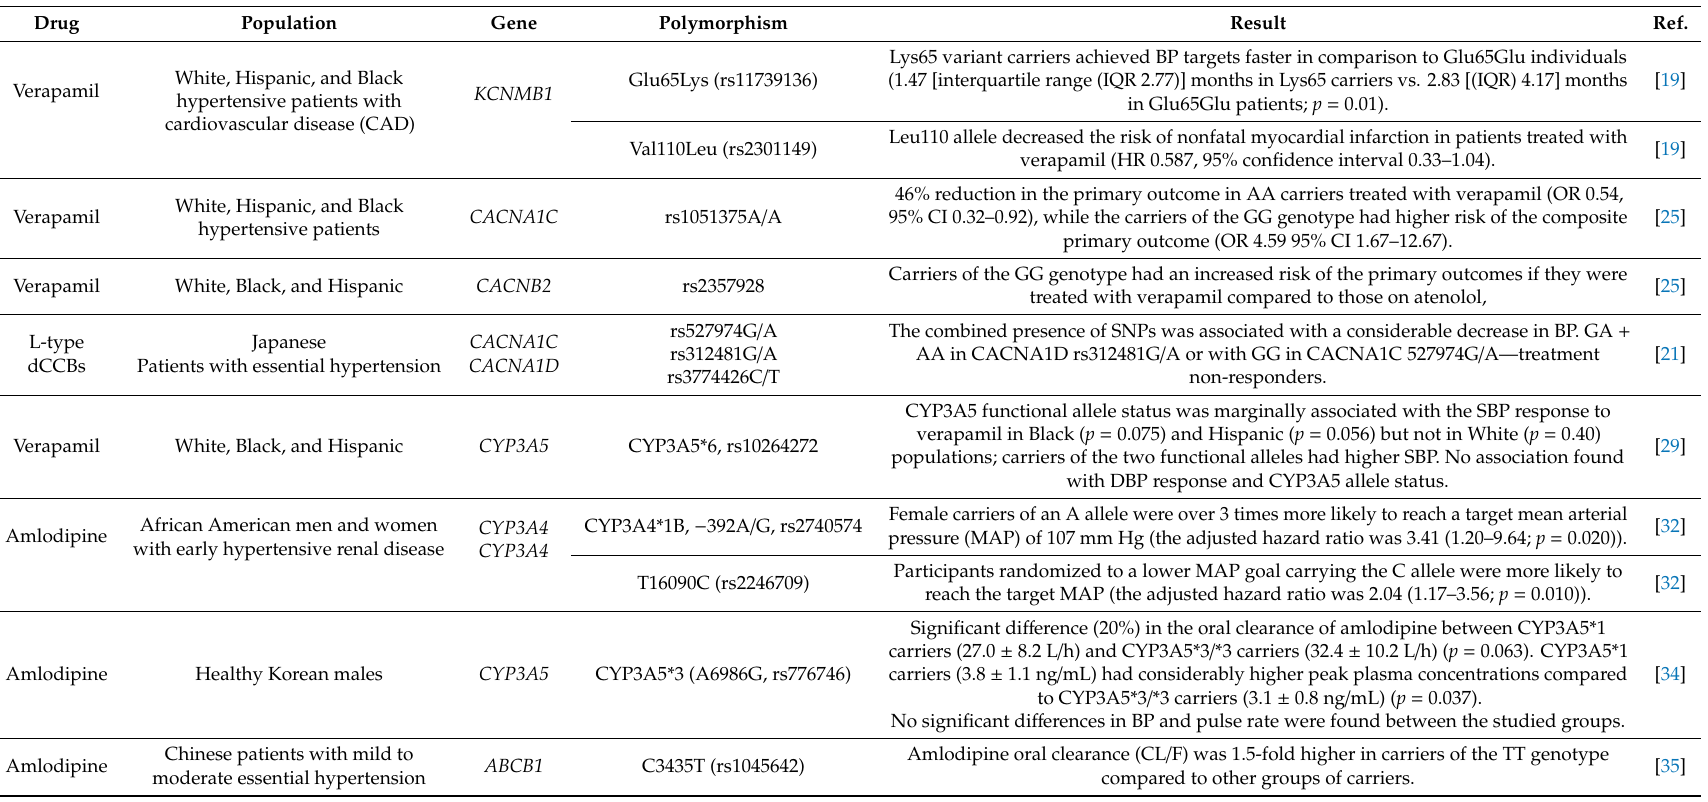
Table 1. A summary of the results of the most interesting studies on CCBs presented in this